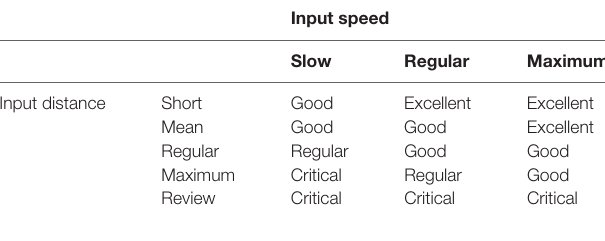
TaBle 2 | Comparison results for the coverage of the three methods, showing the mean ( μ ) and SD. number of